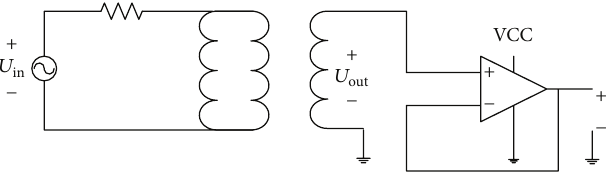
Figure 2: The schematic diagram of DTC antenna.